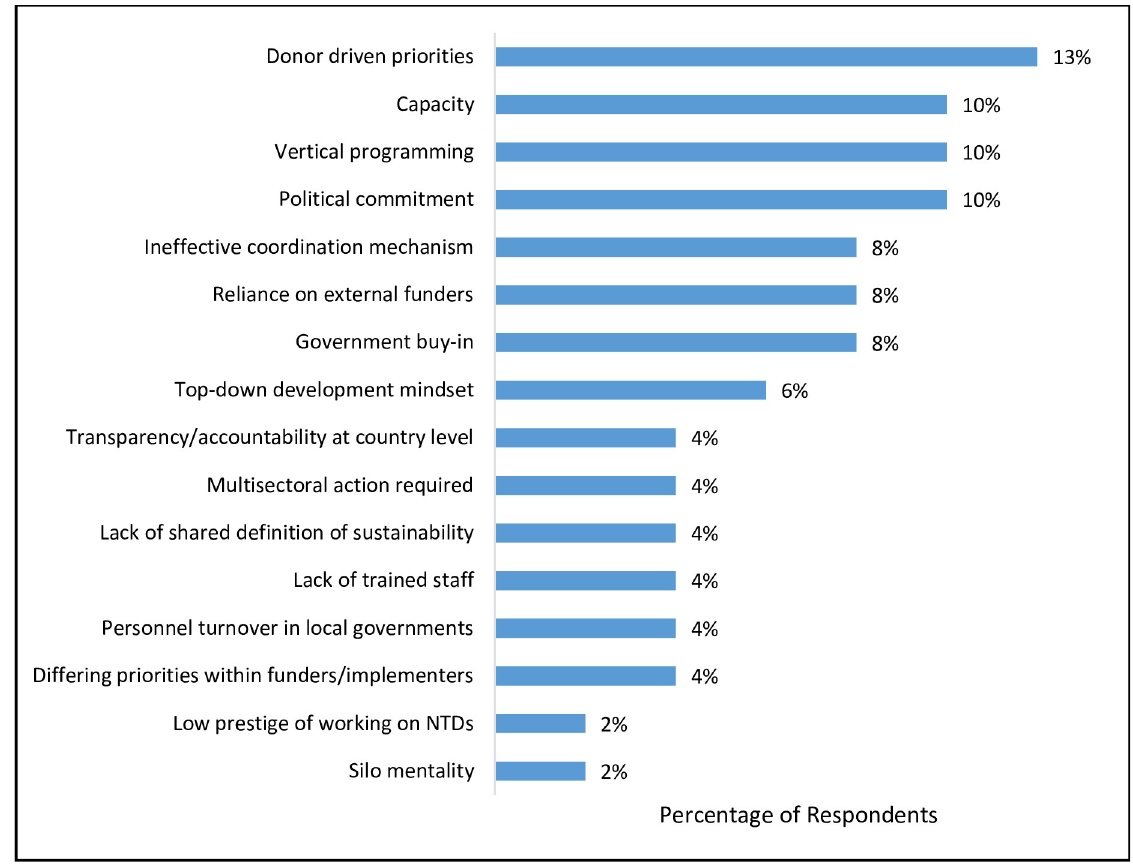
Fig 3. Challenges Mentioned for Achieving